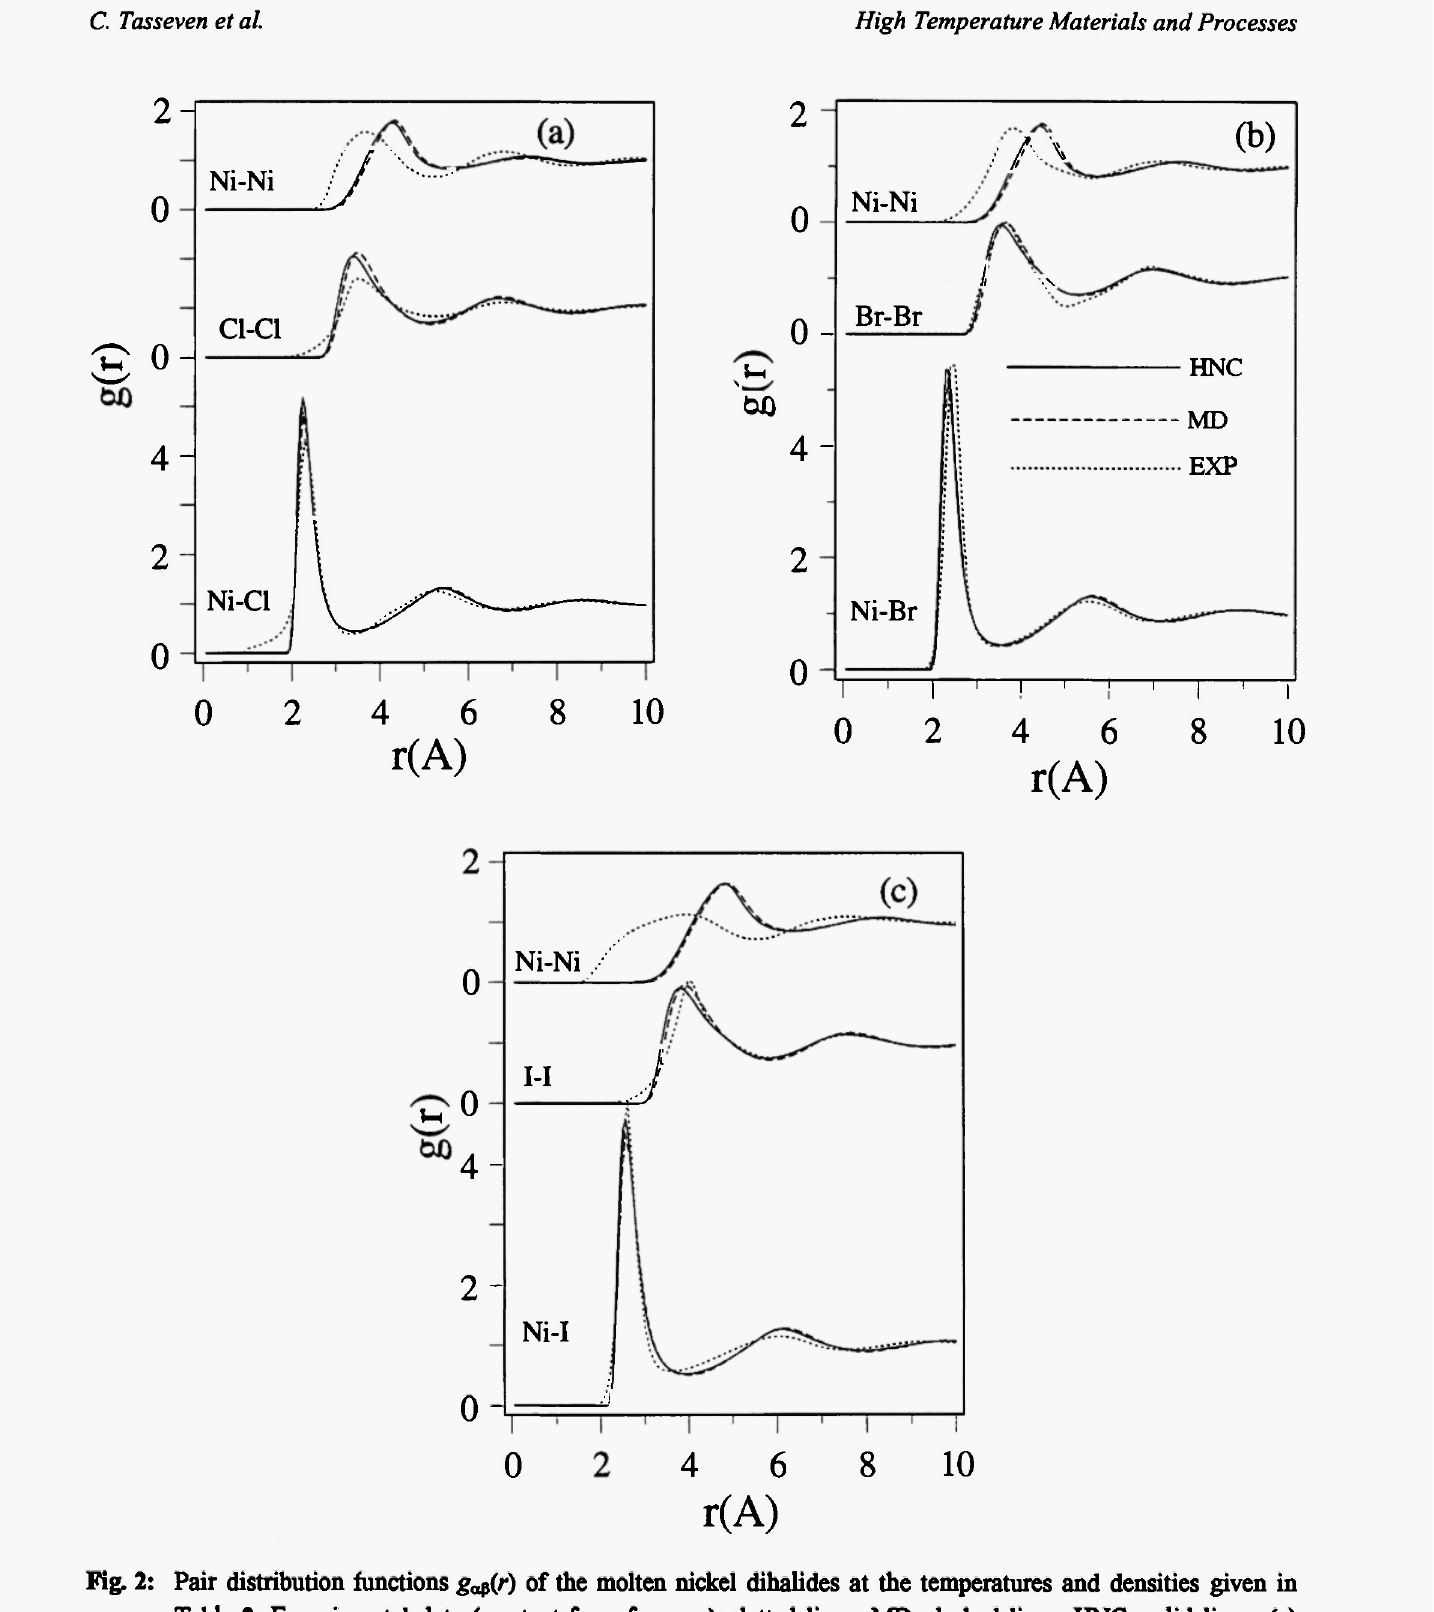
Fig. 2: Pair distribution functions gap(r) of the molten nickel dihalides at the temperatures and densities given in Table 2. Experimental data (see text for references): dotted lines; MD: dashed lines; HNC: solid lines, (a) molten NiCl ; (b) molten NiBr ; (c) molten Nil . 2 2 2